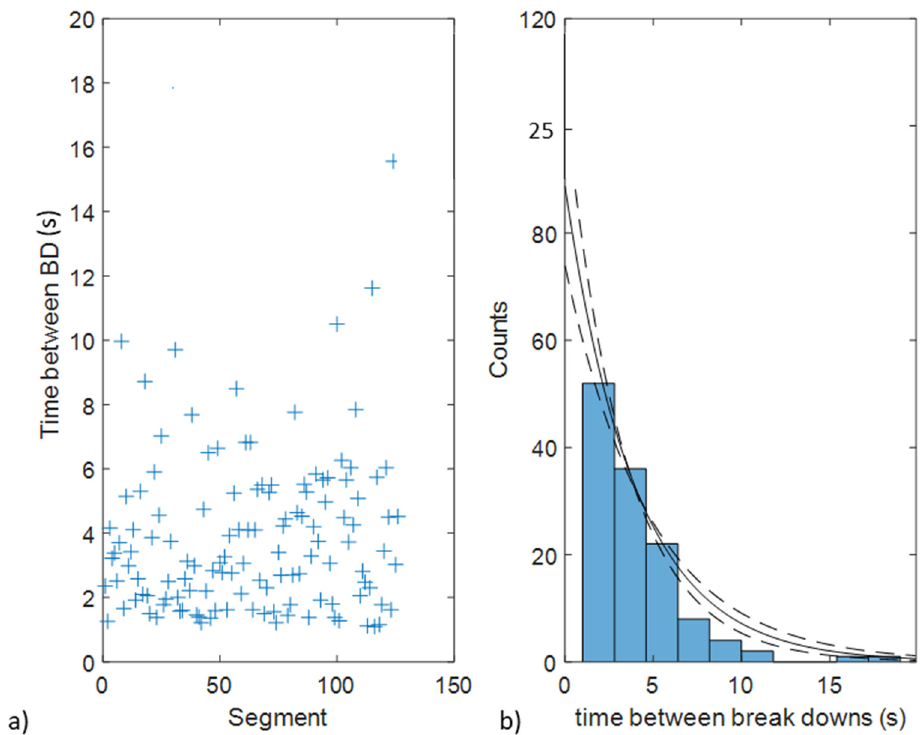
Figure 4. ( a ) Time interval between successive breakdowns (BD) observed at 100 kV peak for a 4 mm free particle in the concentric sphere electrode arrangement filled with 0.75 MPa CO 2 /O 2 , and ( b ) histogram of the time between breakdowns fitted with an exponential distribution function.